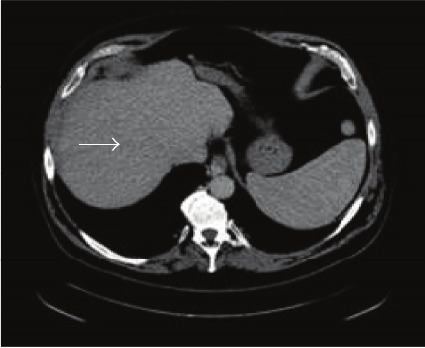
Figure 5: Follow-up CT image at 3 months after hepatic artery revascularization with stent placement showed resolution of liver